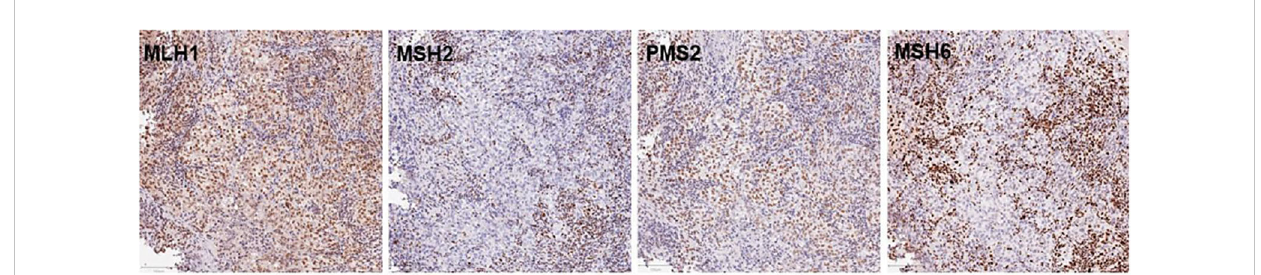
FIGURE 3 Immunohistochemistry for MMR proteins MLH1, MSH2, PSM2, and MSH6. The nuclei of tumor cell were clearly positive for MLH1 and PMS2 staining together with the surrounding non-neoplastic cell nuclei, largely of in fi ltrating lymphocytes. In contrast. MSH2 and MSH6 were negative in tumor cells with positive staining for non-neoplastic cell nuclei, serving as internal positive control for staining. The bars in the lower left corner indicate 100mm.